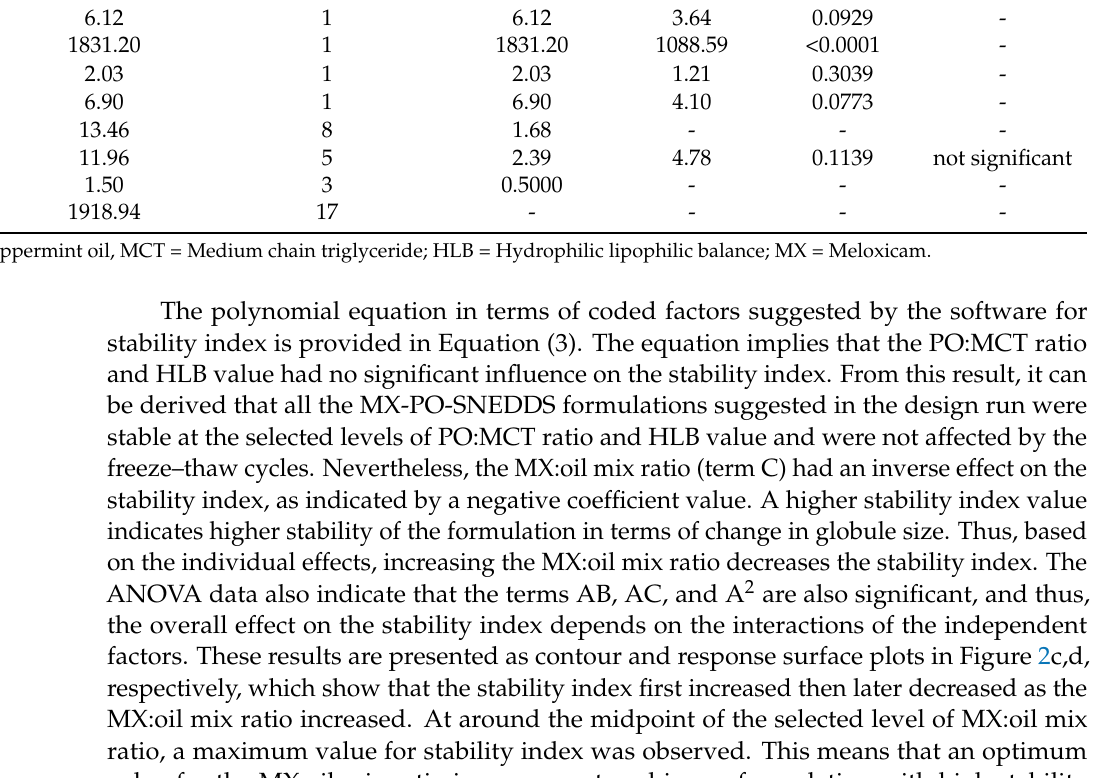
Table 6. ANOVA data for stability index of MX-PO-SNEDDS formulations prepared in various experimental runs. Source Sum of Squares Degrees of Freedom Mean Square F-Value Model